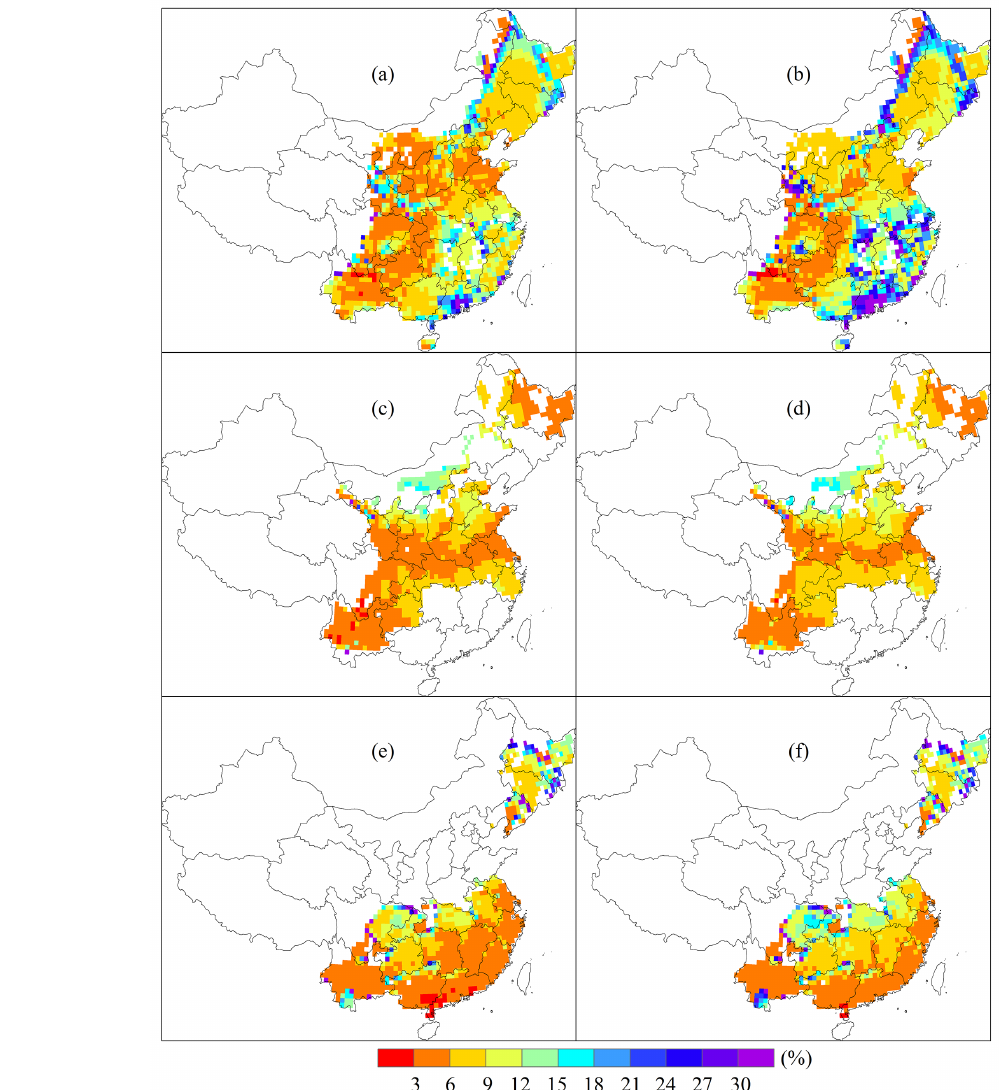
Figure 9. Standard deviation of the projected yield changes for maize (a, b) , wheat (c, d) and rice (e, f) under the 1.5 ◦ C warming (a, c, e) and 2.0 ◦ C warming (b, d, f) scenarios, taking the CO 2 fertilization effect into